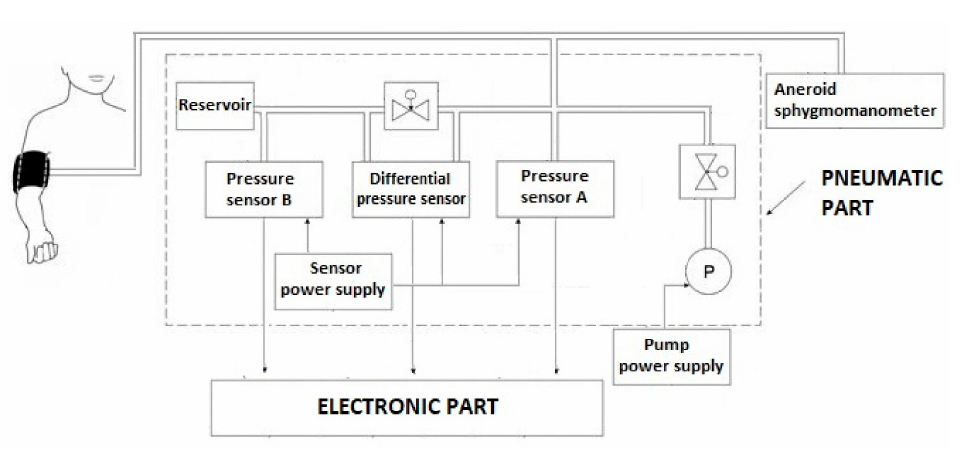
Figure 1. Pneumatic part of experimental device